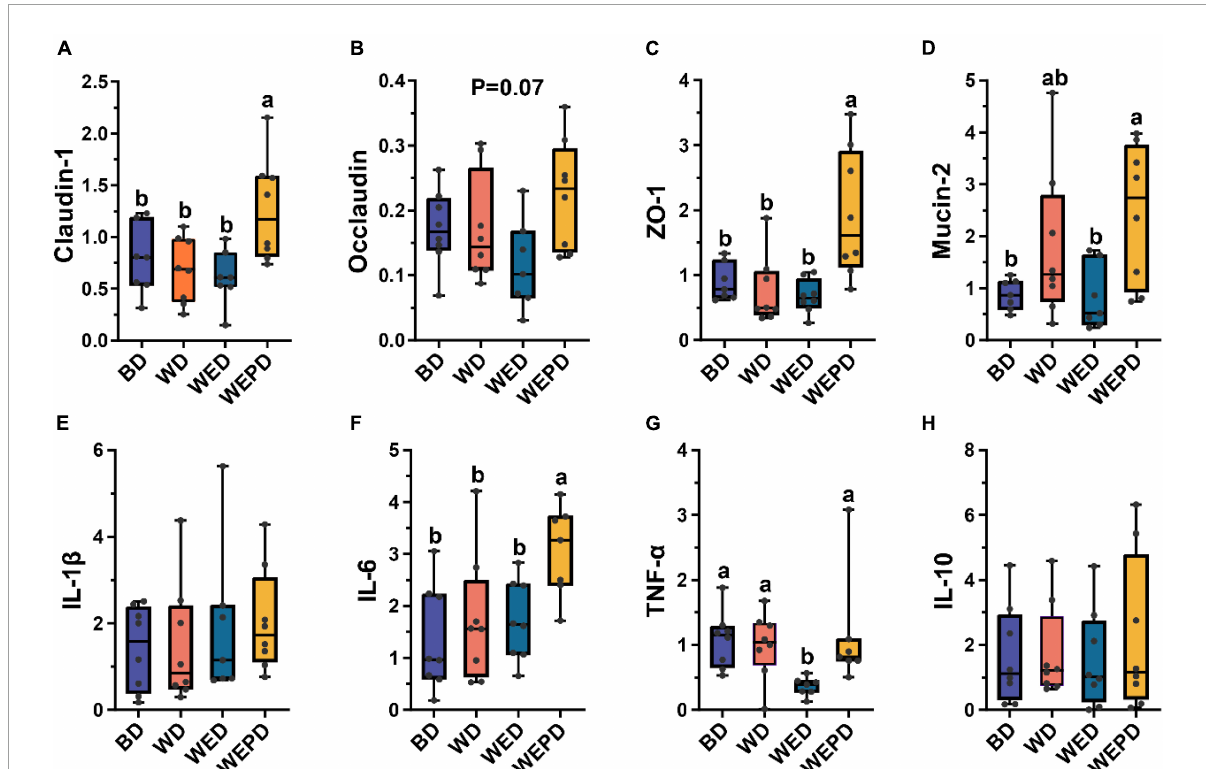
FIGURE1 Expression of inflammatory cytokines and tight junction protein in the jejunal mucosa among different treatments. (A–D) mRNA expression of claudin, occludin, ZO-1, and mucin-2. (E–H) mRNA expression of IL-1 β , IL-6, TNF- α , and IL-10. Data are expressed as min to max showing all points ( n = 7 ∼ 8 broilers/group). Different letters (a, b) means significant differences ( P <